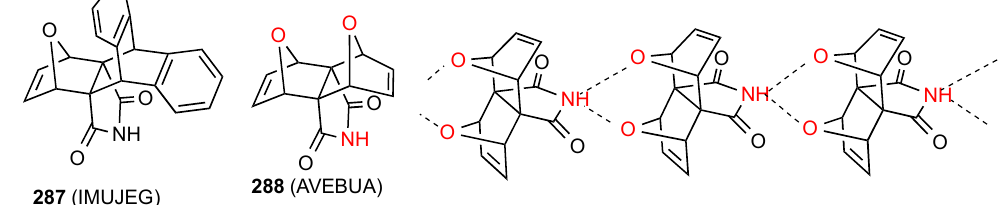
Figure 84. Structure of propellanes.